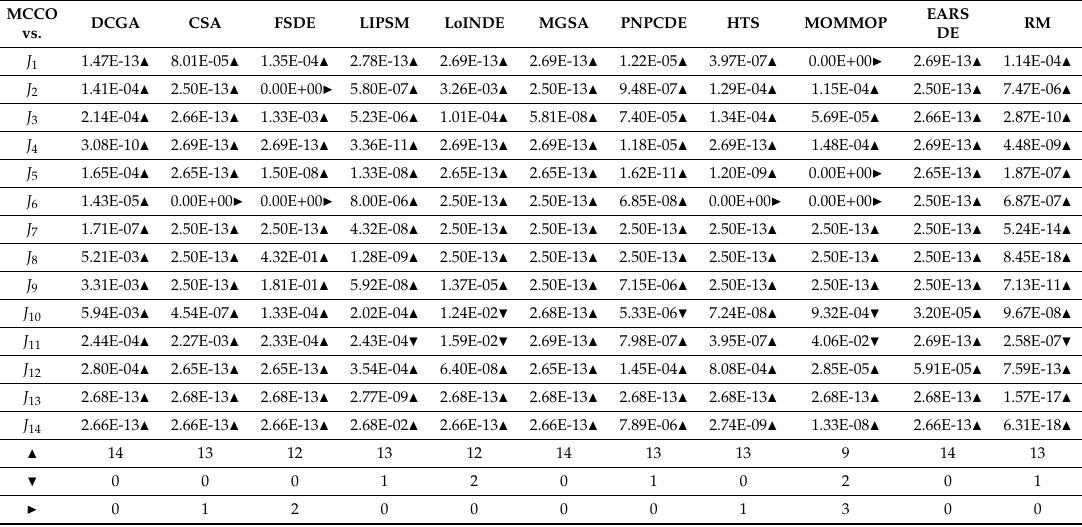
Table 5. p -values produced by nonparametric test comparing MCCO vs. DCGA, MCCO vs. MCCO, MCCO vs. FSDE, MCCO vs. LIPSM, MCCO vs. LoINDE, MCCO vs. MGSA, MCCO vs. PNPCDE, MCCO vs. HTS, MCCO vs. MOMMOP, MCCO vs. EARSDE, and MCCO vs. RM over the EPN performance metric from Tables 2 and